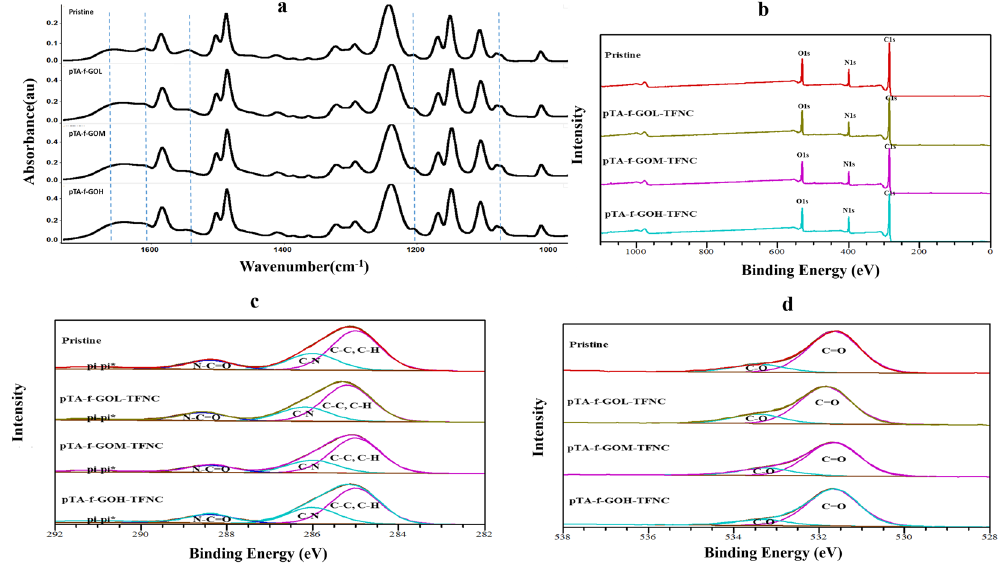
Figure 2. The surface chemistry profile including: FTIR spectra of pristine and pTA-f-GO based membranes ( a ), XPS survey scan profiles of pristine, pTA-f-GO based membranes ( b ) and C1s and O1s high resolution curves ( c and d